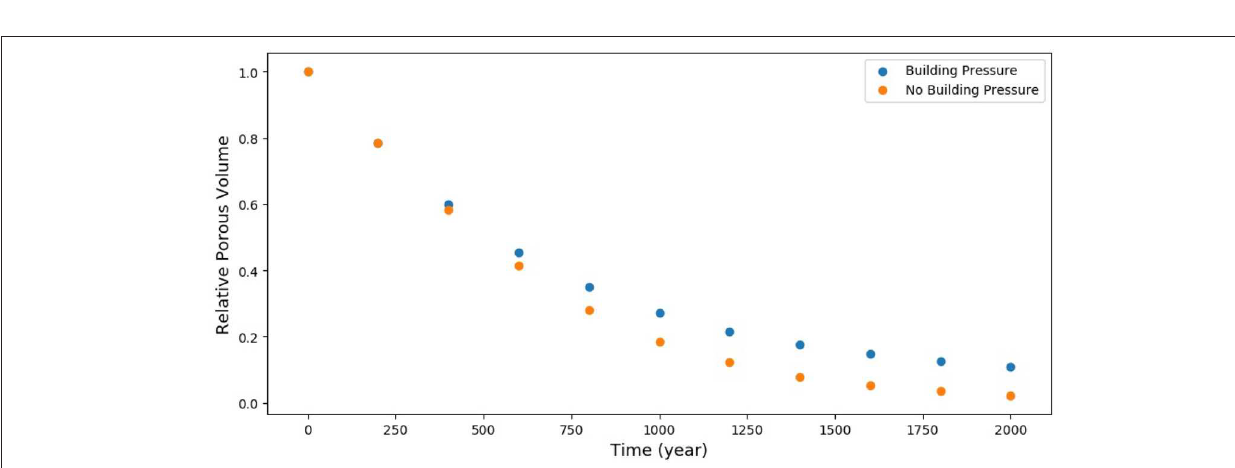
the volume and drops to only 9 individual pores after 700